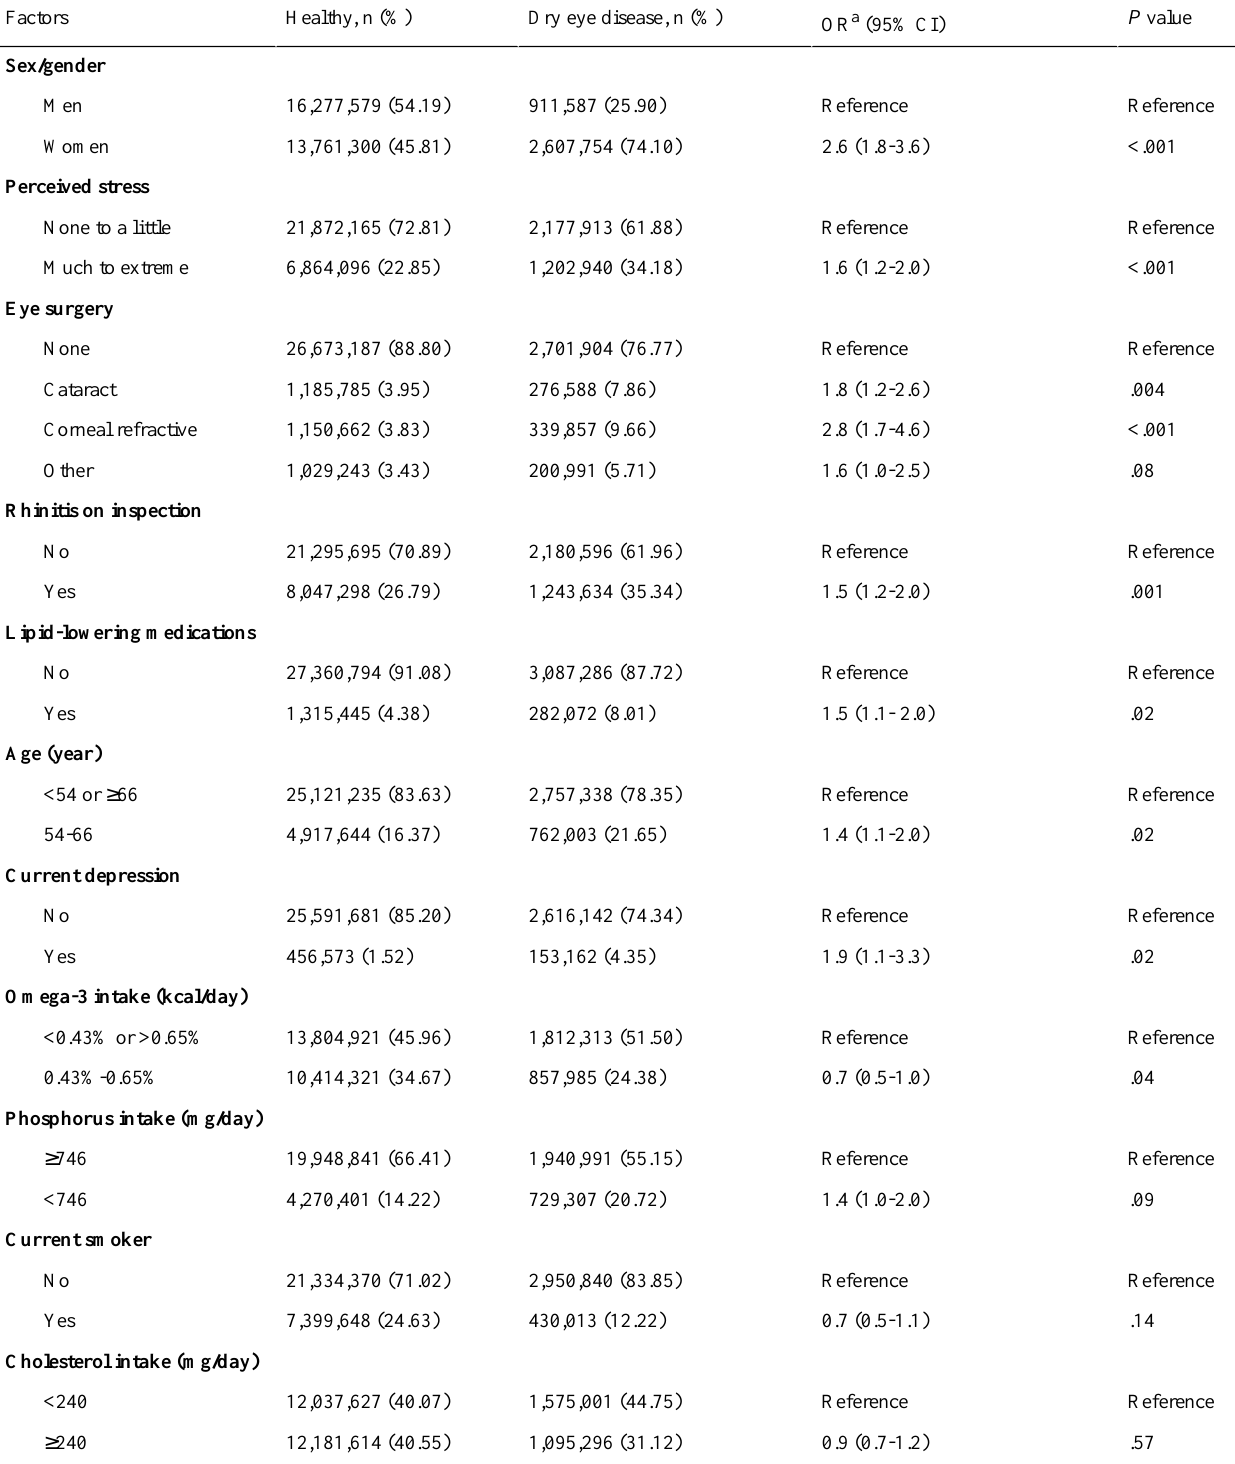
Table 2. Population counts (n), proportions (%), and odds ratios of variables in the points-based scoring system for dry eye